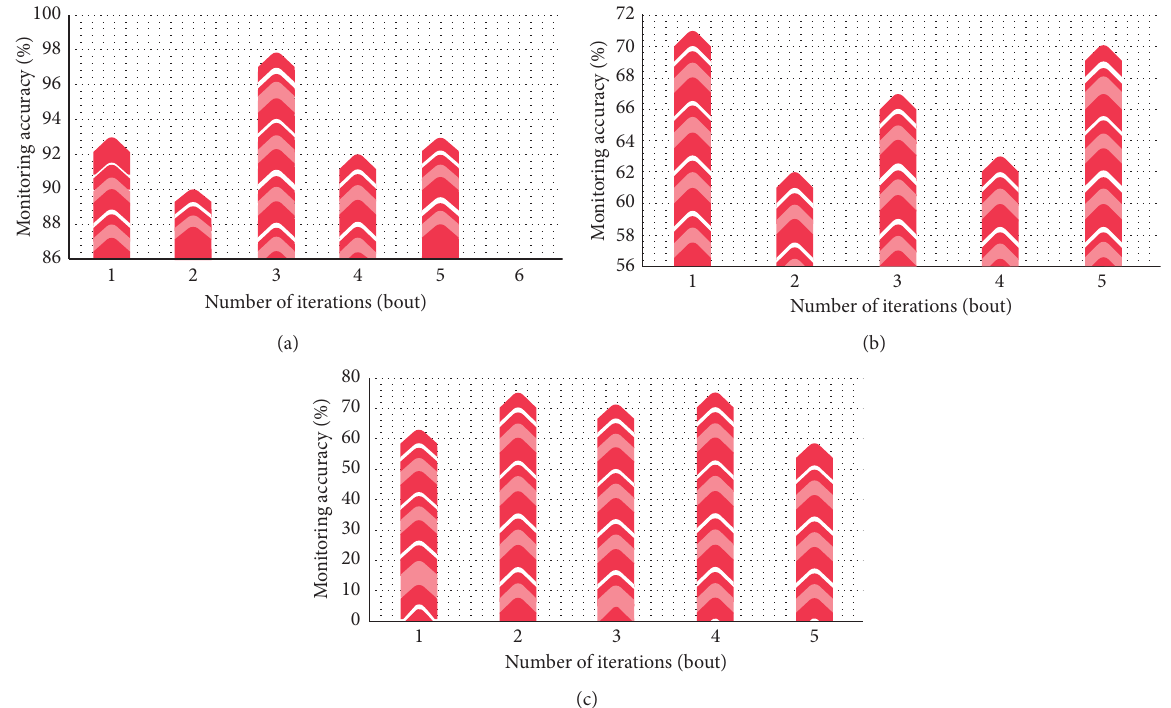
Figure 2: Monitoring accuracy of (a) proposed algorithm, (b) algorithm based on geostationary satellite GOCI, and (c) algorithm based on MODIS